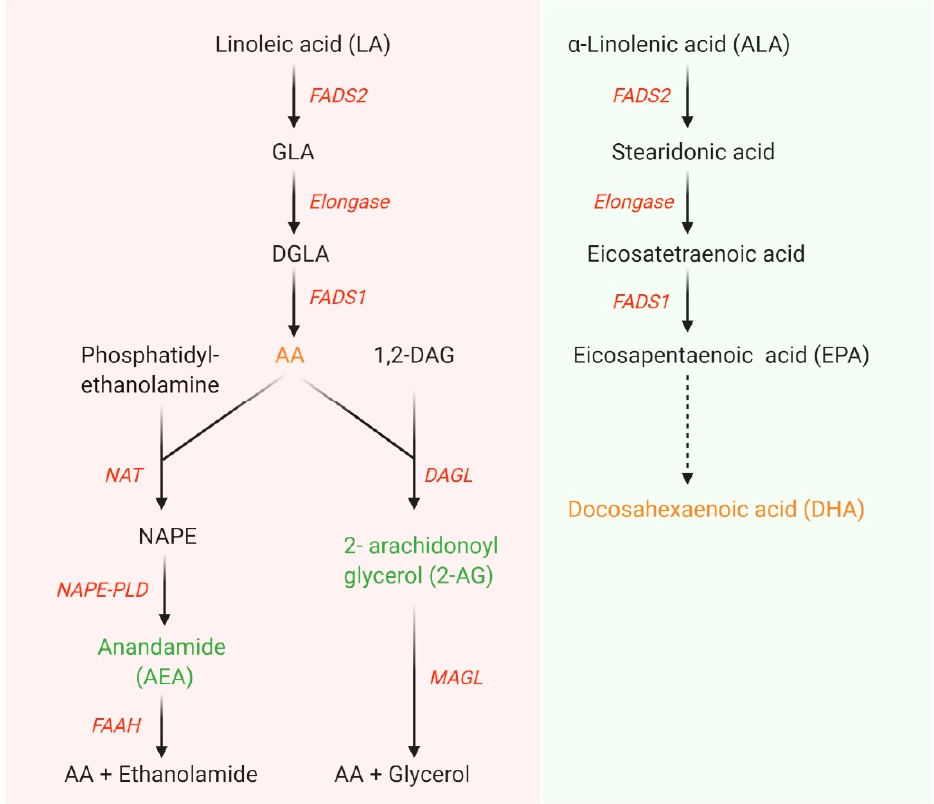
Figure 1. Metabolism of linoleic acid (LA) and α -linolenic acid (ALA). LA and ALA are converted into longer chain polyunsaturated fatty acids in the presence of series of enzymes namely Fads1, Fads2, and elongase. Arachidonic acid (AA) produced from LA involves in the endocannabinoid system pathway. DGLA, dihomo-gamma-linolenic acid; GLA, gamma-linolenic acid; FADS, fatty acid desaturase; 1,2-DAG, 1,2-diacylglycerol; NAPE, N-arachidonoylphosphatidylethanolamine; NAPE-PLD, NAPE-phospholipase D; FAAH, fatty acid amide hydrolase; NAT, N-acyltransferase; DAGL, diacylglycerol lipase; MAGL, monoacylglycerol lipase. Figure adapted from [9,10] and prepared in